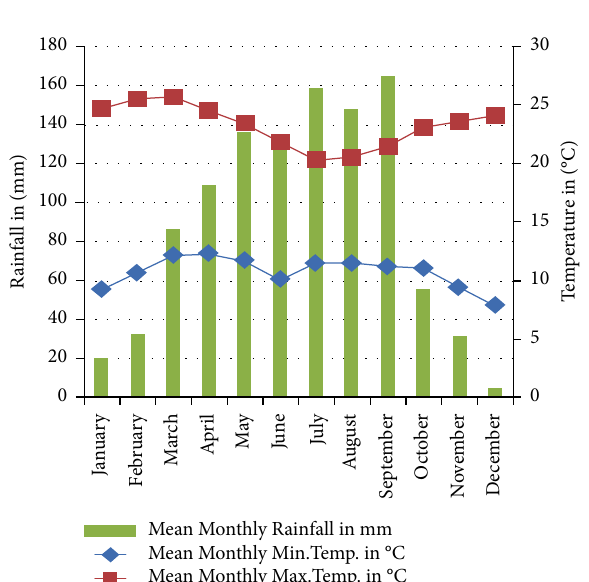
Figure 2: Mean monthly rainfall and temperature of the study